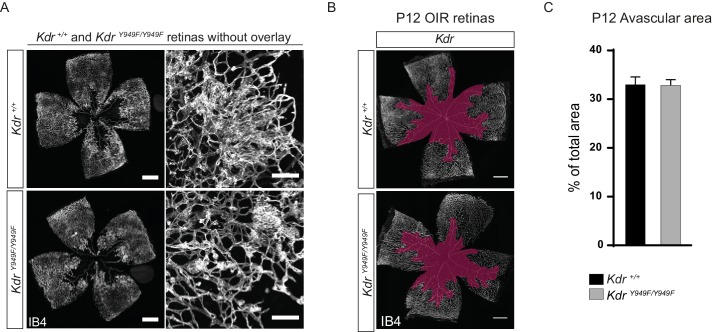
Retina vasculature following OIR.(A) Whole mount retinas from KdrY949F/Y949F and Kdr+/+ as shown in Figure 2 but displayed without overlays. Panels showing close up of tuft detail are placed to the right-hand side of each full retina image. Scale bar = 500 µm. Inset scale bar = 100 µm. (B) Whole mount retinas collected at P12, after the vessel destruction phase of OIR and before extensive vessel regrowth, stained with isolectin B4 (IB4), showing no difference in the extent of vessel loss between KdrY949F/Y949F and Kdr+/+ mice, Scale bar = 500 µm. Avascularity shown with purple overlay. (C) Quantification of B).